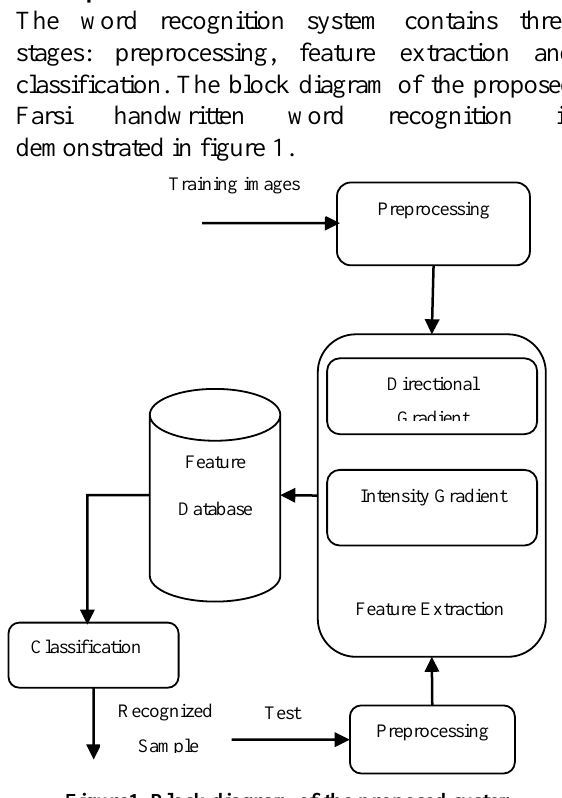
Figure1. Block diagram of the proposed